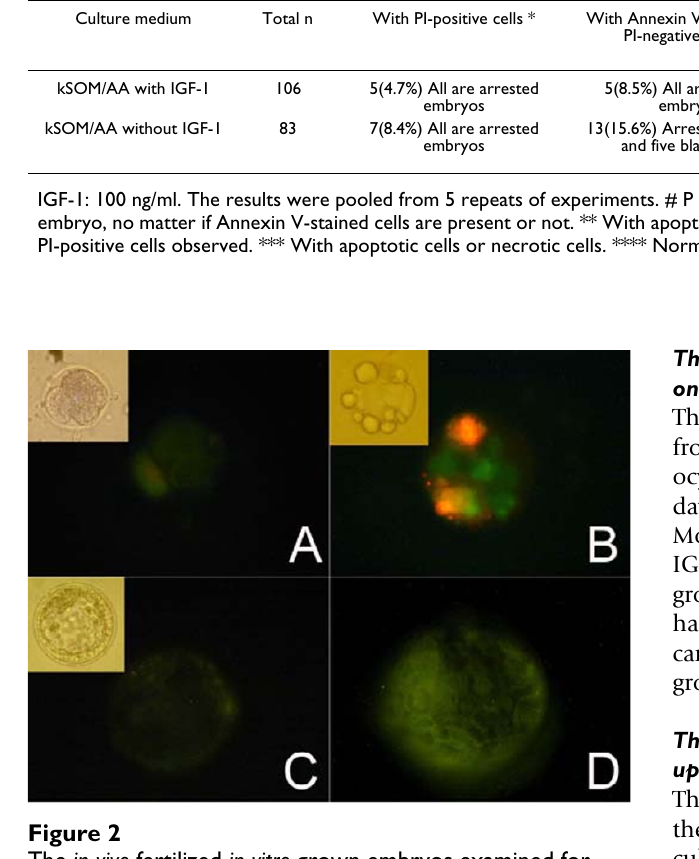
Table 2: The effect of IGF-1 upon the in vivo fertilized embryos examined for apoptosis and necrosis with fluorescent microscopic examination of PI and Annexin V staining. Study